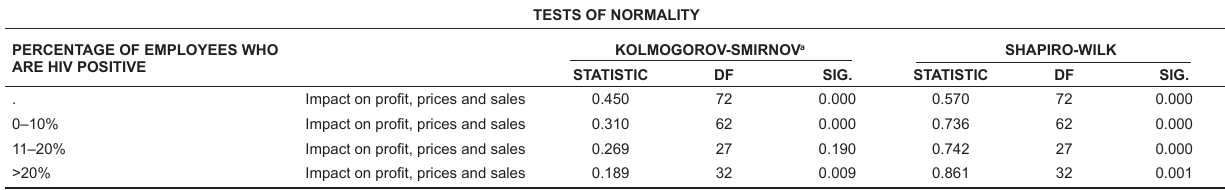
TABLE 19 Tests of normality (question 11) TESTS oF NoRMALITY